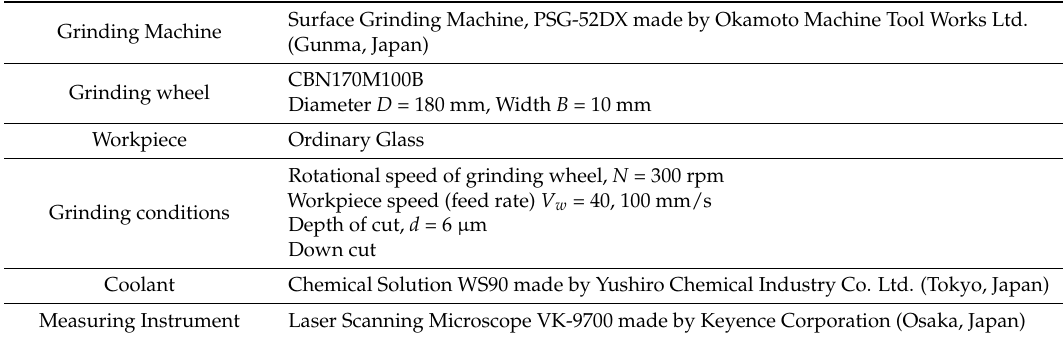
Figure 12. Surface topography of ground surface for feed rate V w = 100 mm/s.